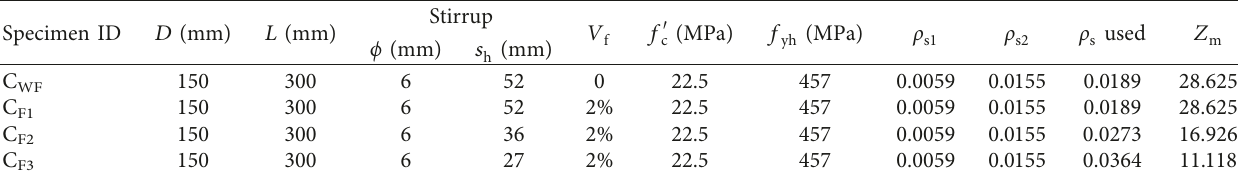
Table 3: Unconfined concrete specimens without steel fiber.